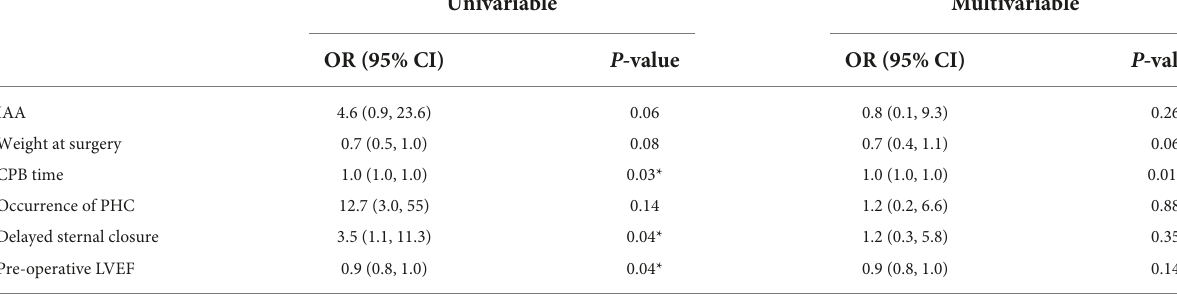
TABLE 4 Univariable and multivariable analysis for risk factors of early mortality by logistic